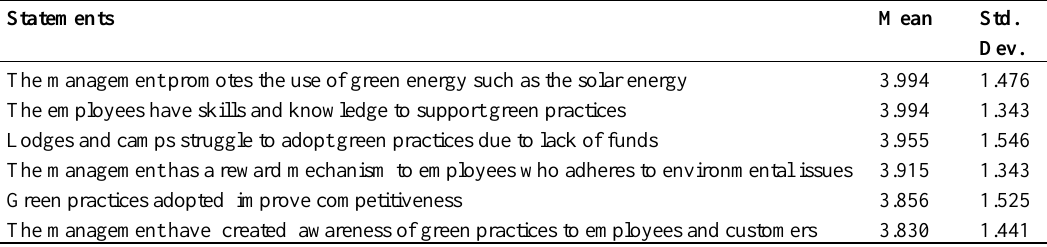
Table 2: Organizational Commitment in Lodges and Tented